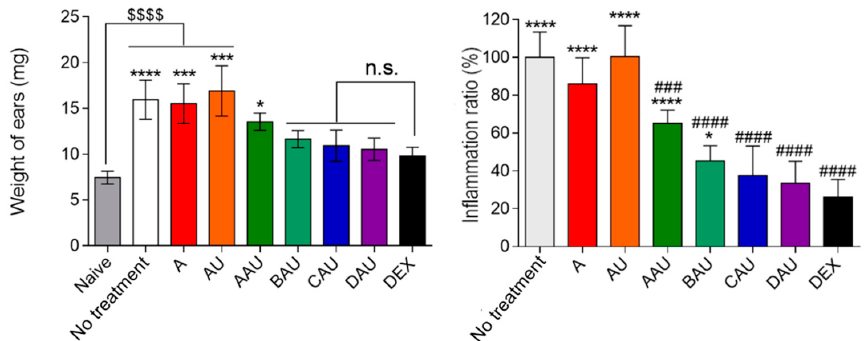
Figure 4. Anti-inflammatory activity of the colloidal systems with ursolic acid. The vehicle is the A formulation, and the control is an ointment containing dexamethasone 0.5% ( w / w ). Left graph shows weight of ears and right graph shows the inflammatory index (%) obtained. The data represent the mean ± S.D. of 5 mice. The statistical significances of ear thickness and inflammatory index were analyzed using variance analysis following Tukey’s multiple comparison test; * p < 0.05 , *** p < 0.001, **** p ≤ 0.0001, and n.s. p > 0.05 compared to dexamethasone group; $$$$ is p ≤ 0.0001 compared to naïve group; ### p < 0.001 and #### p ≤ 0.0001 compared to no treatment group. A = formulation with OA%/S%/W% ratio of 40/50/10; B = formulation with OA%/S%/W% ratio of 30/50/20; C = formulation with OA%/S%/W% ratio of 20/50/30; D = formulation with OA%/S%/W% ratio of 10/50/40; AAU = formulation A loaded with AU; BAU = formulation B loaded with AU; CAU = formulation C loaded with AU; DAU = formulation D loaded with AU; DEX = dexamethasone.